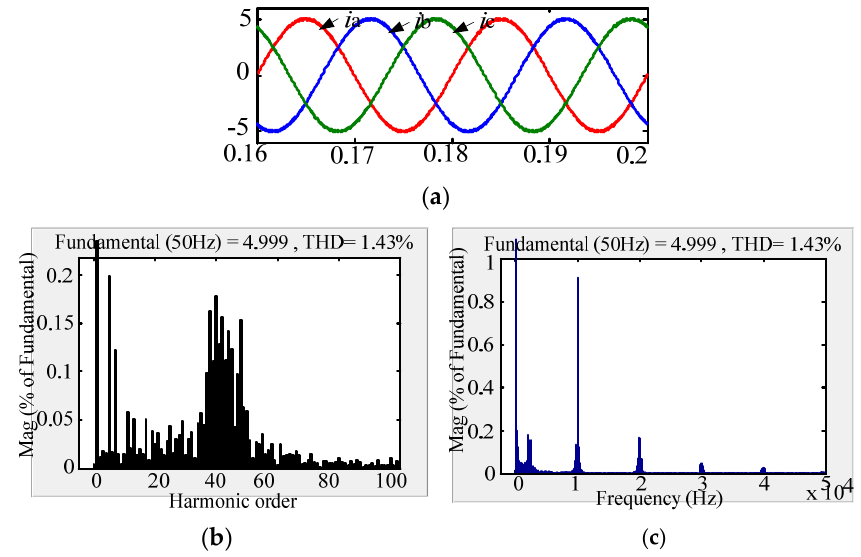
Figure 11. AC-side current waveform of split inductor damping solution 1. ( a ) AC-side current; ( b ) Low-frequency harmonic analysis; ( c ) High-frequency harmonic analysis.